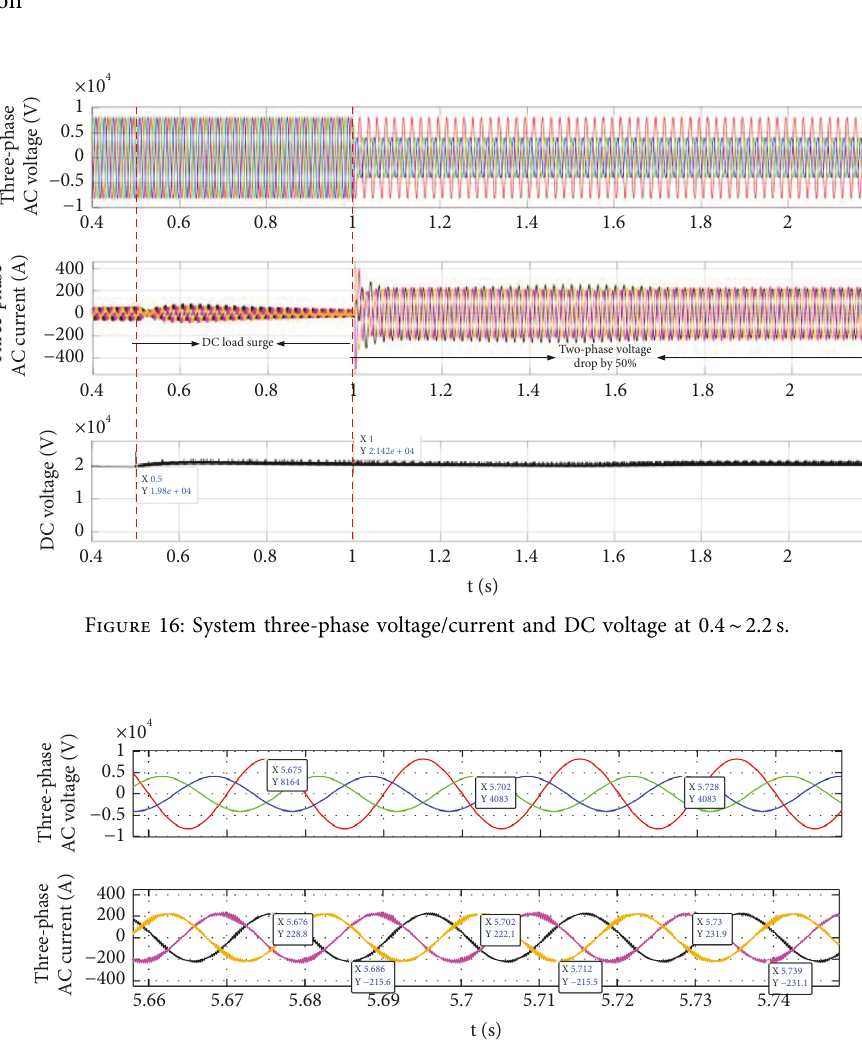
Figure 17: Three-phase AC voltage and current at 5.66s ∼ 5.76s.